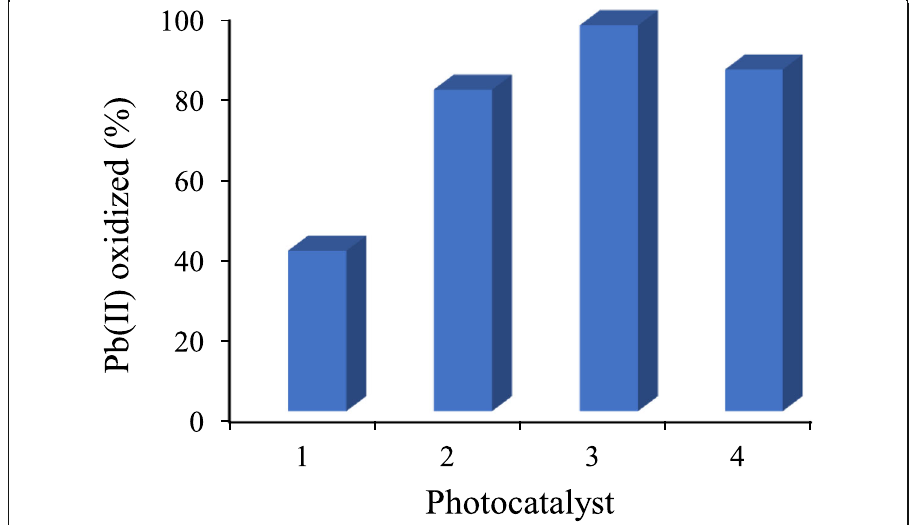
2 -N,S(1:1:1), and (4) TiO 2